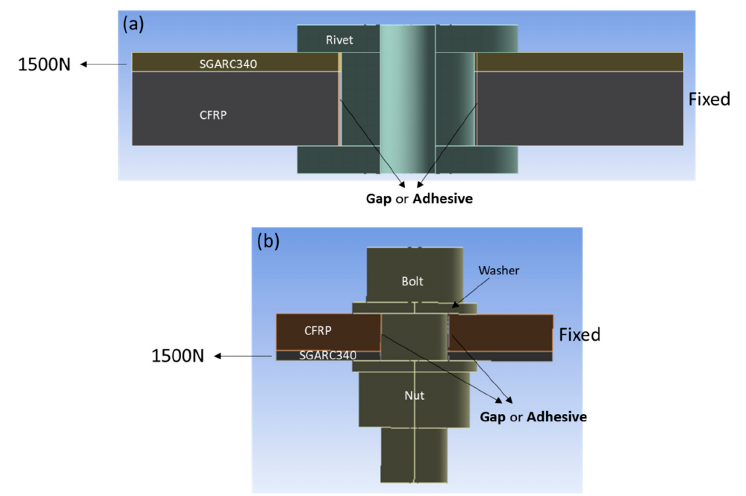
Figure 2. Geometric models for numerical analysis: ( a ) rivet and ( b ) bolt.